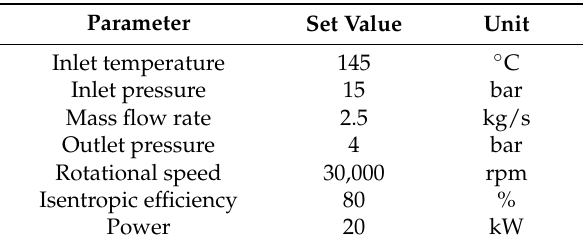
Table 2. Design parameters of the turbine.